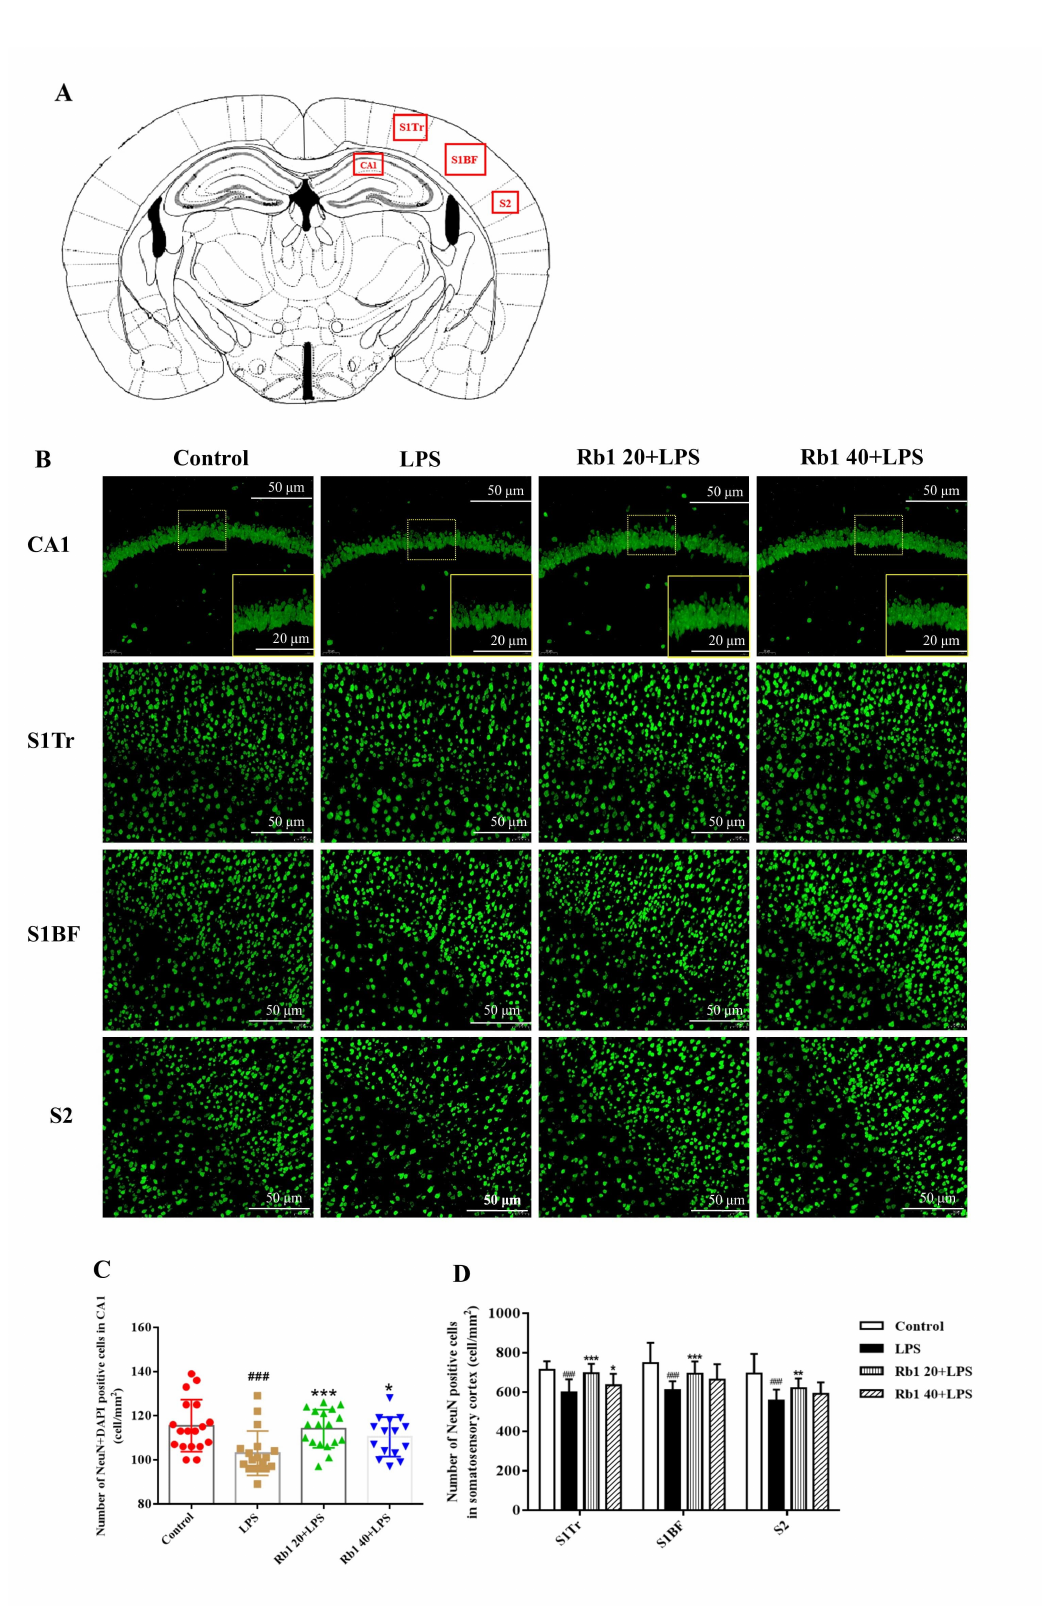
Fig. 4. Rb1 attenuated neuron loss in the brain following LPS treatment. Immunostaining was performed 24 h after LPS i.p. injection. The NeuN positive cells in CA1, S1Tr, S1BF, and S2 were monitored (Red boxes) (A). The immunostaining of NeuN-labeled cells (Green) was presented in CA1, S1Tr, S1BF, and S2 areas (B). NeuN+DAPI or NeuN positive cells in the hippocampus (C) and somatosensory motor cortex (D) were counted. Data are represented as mean ± SD (n = 6). ### p < 0.001 versus the control group; * p < 0.05, ** p < 0.01, and *** p < 0.001 versus the LPS